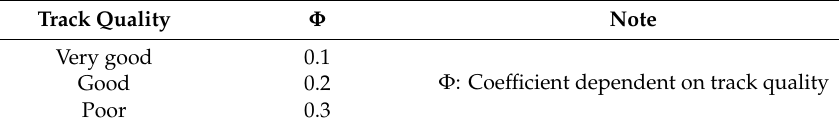
Table 3. Track quality and application